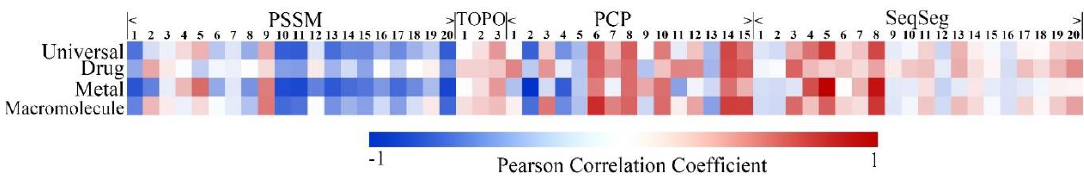
Figure 3. The heat map of the Pearson correlation coefficient between features and labels. Red represents positive correlations and blue represents negative correlations. The darker the color, the higher the correlation.